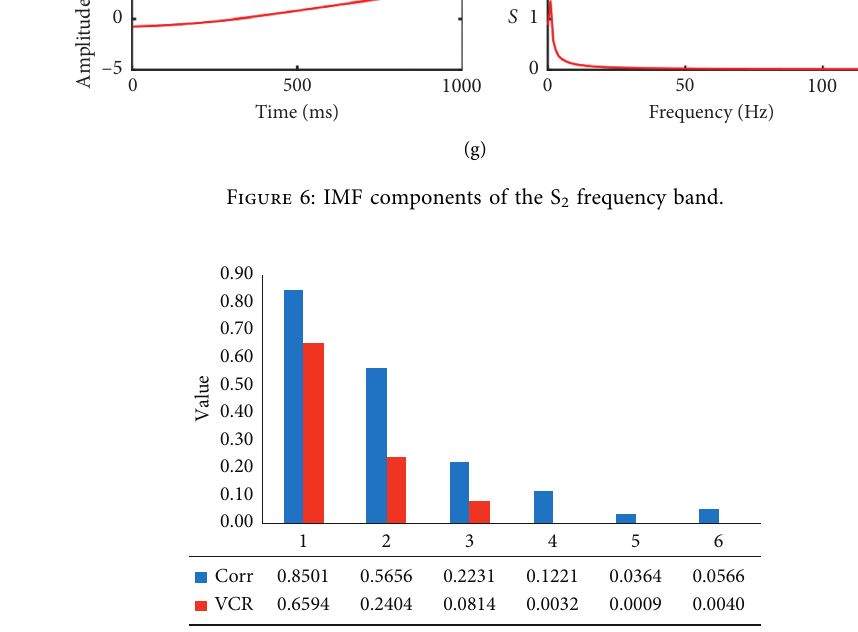
Figure 7: Correlation coefficient and variance contribution rate for IMF